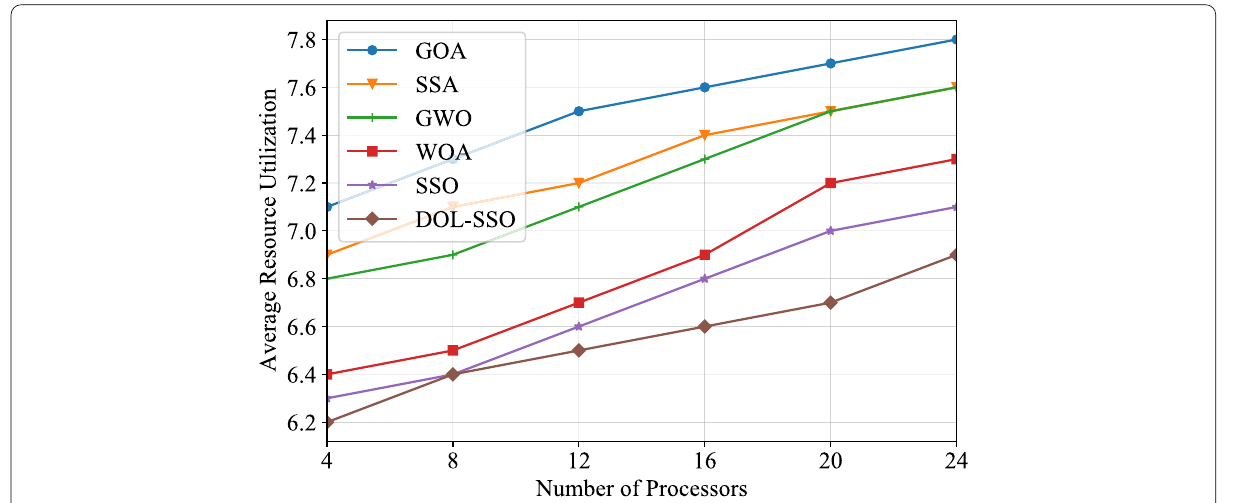
Fig. 4 Average Energy Consumption Ratio concerning the number of